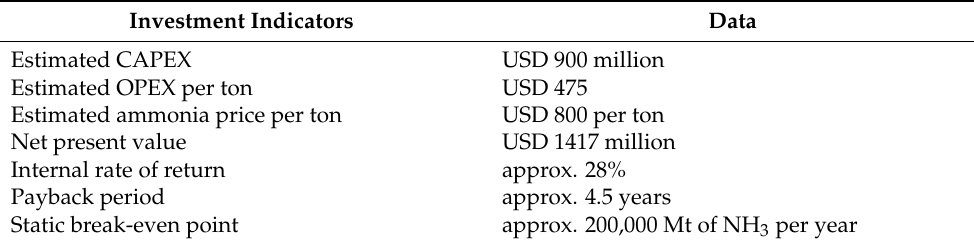
Table 3. Investment indicators from classical capital